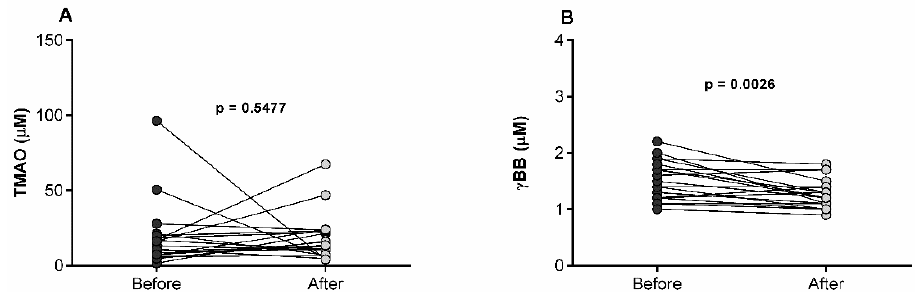
Figure 2. Serum TMAO ( A ) and γBB ( B ) levels in morbidly obese subjects at baseline and one year after bariatric surgery. Each pair of symbols with a line represents a participant before and after bariatric surgery. Wilcoxon matched-pairs signed rank test was performed to compare data. Table 2. Characteristics of T2D patients before and after glycemic optimization, and obese subjects before and after bariatric surgery. Spear man correlation parameters of delta TMAO and delta γBB, with biochemical parameters that are significantly altered in T2D patients, are shown in Table 2. Neither delta TMAO nor delta γBB were significantly correlated with any of deltas studied. In obese patients, we only found a slightly significant correlation of delta TMAO with delta ALT and delta AST, curiously in an opposite direction (Table 3).